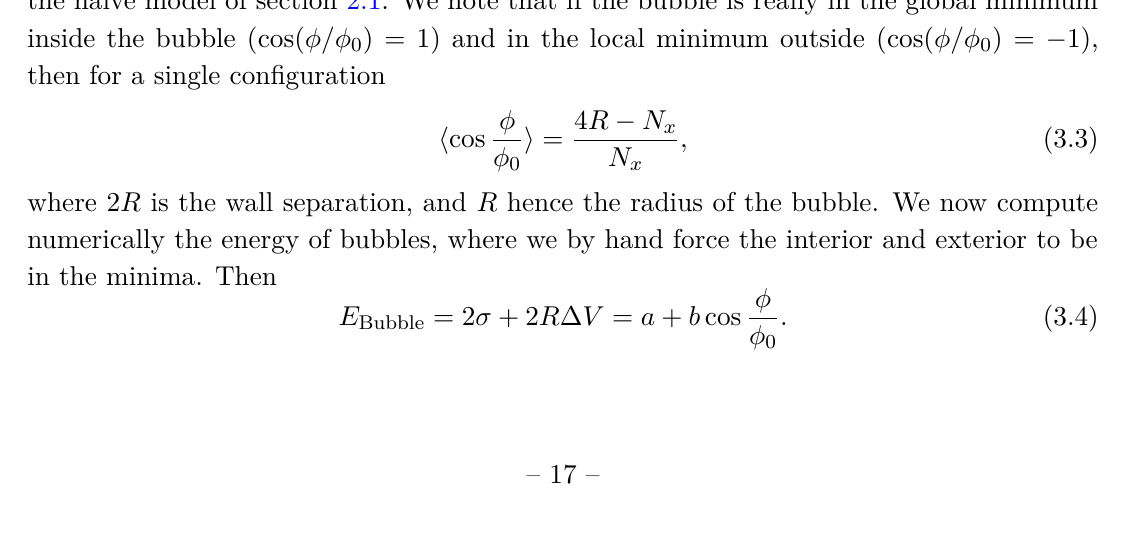
Figure 10 . The energy of two bubble walls and the bubble interior versus h cos φ parameters are N = 512 , φ = 0 . 5 and (cid:15) = 0 . 17 x 0